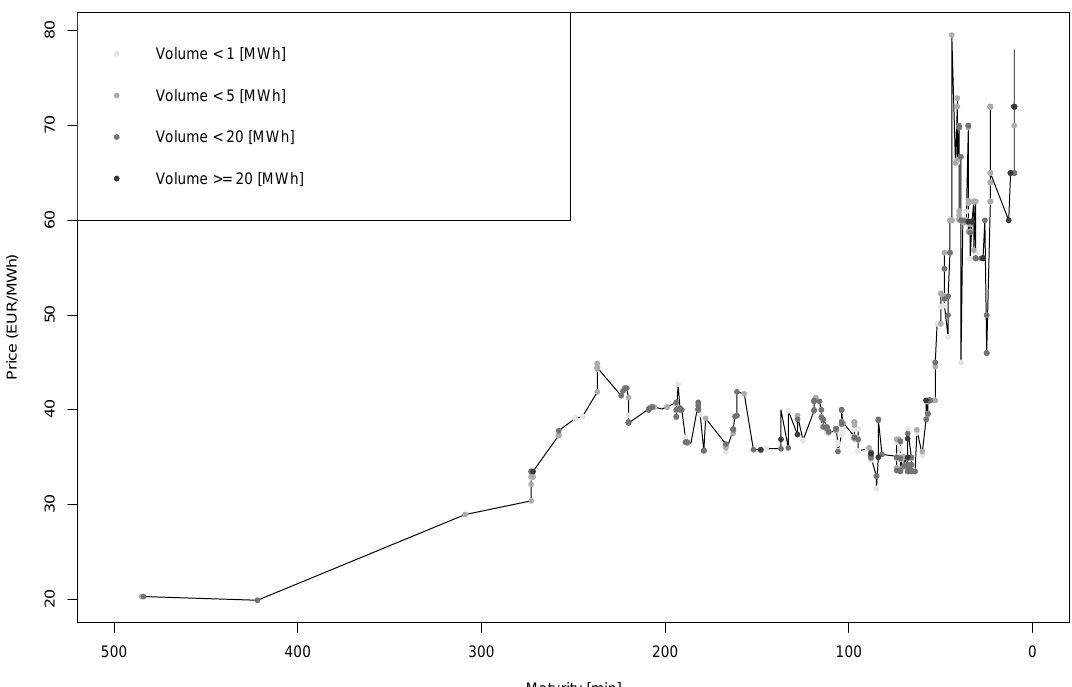
Figure 2. Selected realized price development of the 00h–01h contract on 23 September 2018 with remaining maturity of the continuous intraday market. The figure illustrates the differences between a classic stock market and the continuous intraday market for electricity. There are large price movements from about EUR 20 to 80 per MWh within the few hours of trading. Furthermore, trades are unevenly distributed and cluster at the end of the period.